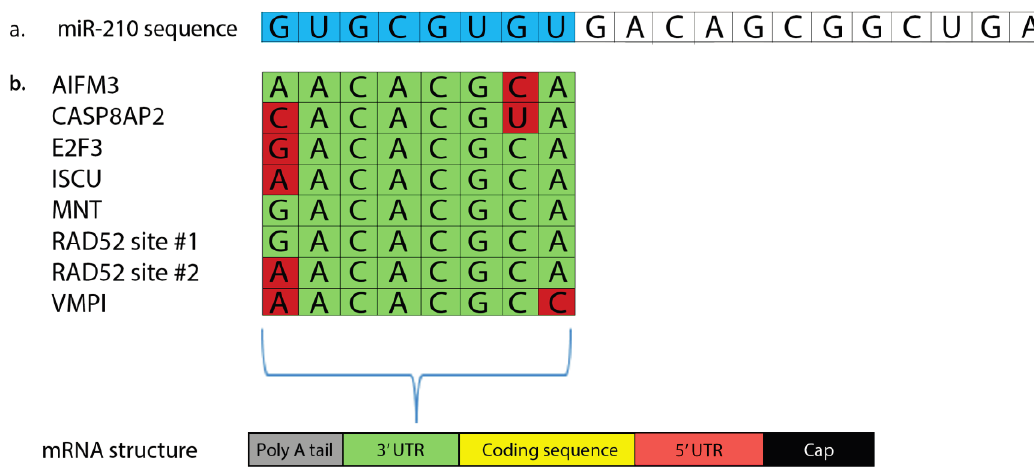
Figure 1. miR-210 binds to the 3' UTR of target mRNAs in order to modulate their transcription. ( a ) Entire mRNA sequence with seed region highlighted in blue; ( b ) 3' UTR of some of miR-210’s target mRNAs. Bases that successfully pair to miR-210’s seed region are highlighted in green. Bases that do not successfully pair are highlighted in